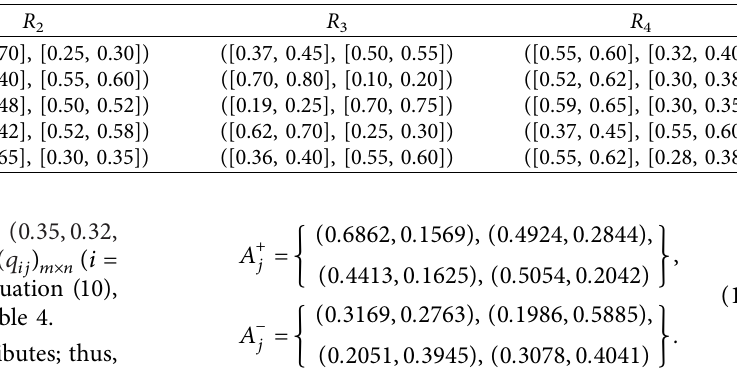
Table 3: Decision-making information given by H